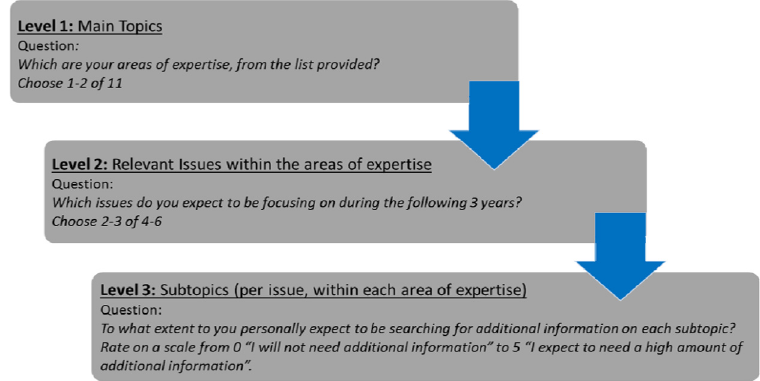
Figure 2. Levels of questions regarding knowledge needs, structured by a top-down